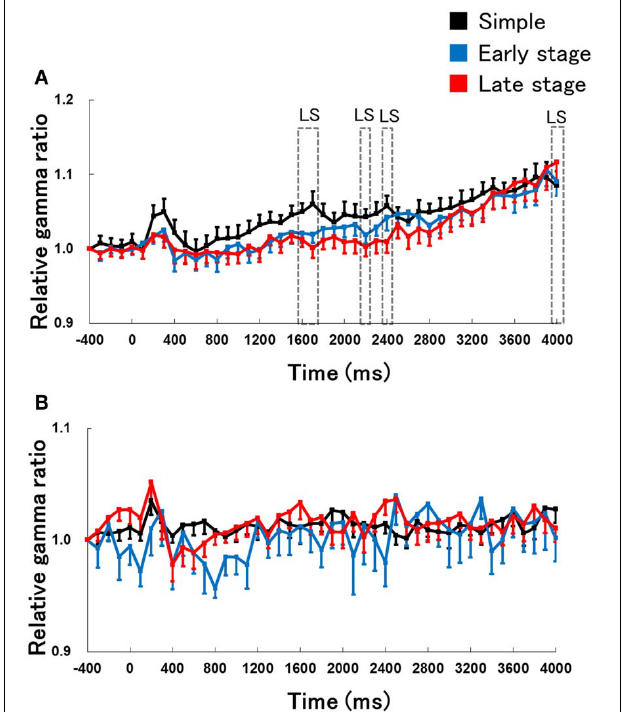
FIGURE 6 | The relative change in hippocampal gamma power during the RFTs (A) and non-RFTs (B) of the retention test for the simple discrimination task (Simple), the early learning stage (Early stage), and the late learning stage (Late stage) of the FN task. The 0-ms period indicates the onset of stimulus presentation. The period was divided into 45 sub-periods of 100ms each. The mean hippocampal gamma power (30–100Hz) from 500 to 400ms before the stimulus onset was counted as the − 400-ms period (no stimuli were present and no rats pressed the lever during this period), and the relative gamma power calculated for each period was normalized to that of the − 400-ms period (relative gamma power of each period = gamma power of each period/gamma power at the − 400-ms period). The “LS” indicates a significant difference between the late learning stage of the FN task and the retention test for the simple discrimination task (LS: p < 0 . 05 ). Error bars indicate